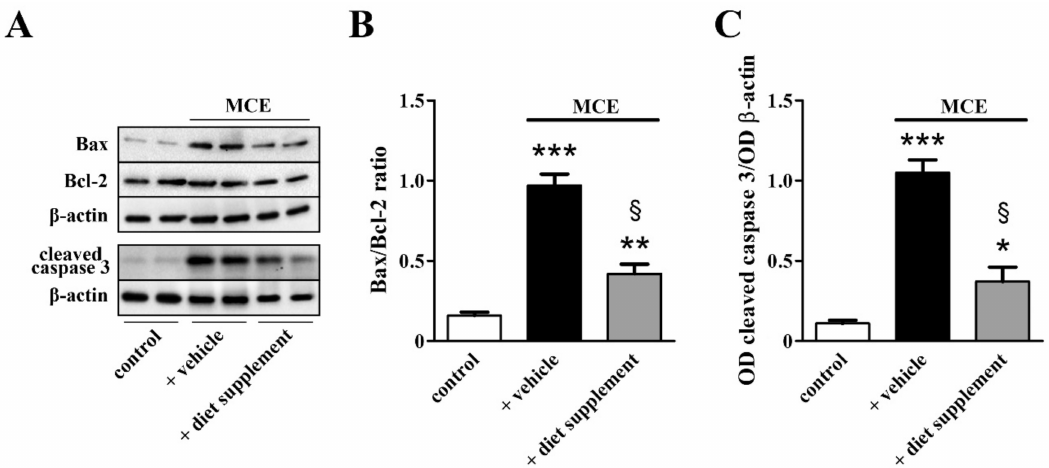
Figure 7. E ff ects of dietary supplementation on apoptotic markers. ( A ) Representative Western blots from retinal homogenates of control mice or mice that received MCE fed with either vehicle or diet supplement. ( B , C ) Densitometric analysis of the levels of Bax / Bcl-2 ( B ) and active caspase 3 ( C ). MCE resulted in increased levels of both Bax and active caspase 3 without altering Bcl-2 levels. Dietary supplementation prevented the upregulation of both Bax and the active form of caspase 3 ( n = 6 for each group). * p < 0.05, ** p < 0.01 and *** p < 0.001 versus control; § p < 0.001 versus MCE mice fed with vehicle (one-way ANOVA followed by the Newman–Keuls multiple comparison post-hoc